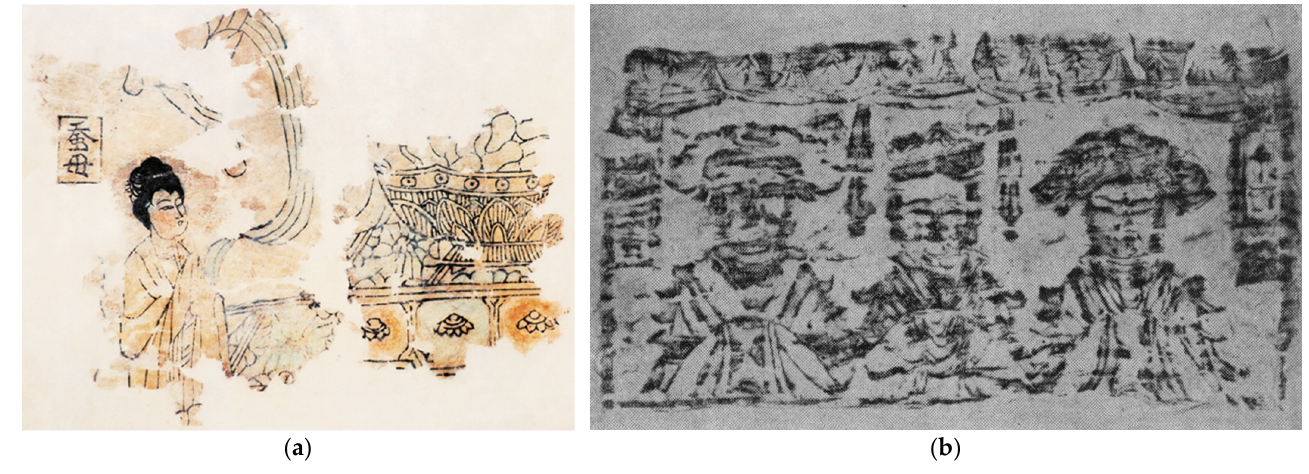
Figure 2. Silkworm deity images in wood engravings of the Northern Song Dynasty: ( a ) “Silkworm mother 蚕母 ” (Chen 2020, pp. 59–62) 2 . Colorful wood engraving. Guoan 国安 temple stone tower in Wenzhou, Zhejiang, China; ( b ) “San-Gu Zhi Can 三姑置蚕 ” (Shi 1981, pp. 70–71) 3 . Book of rubbings. Wood engravings from the Northern Song Dynasty (960–1127). Collected at the National Museum of China.